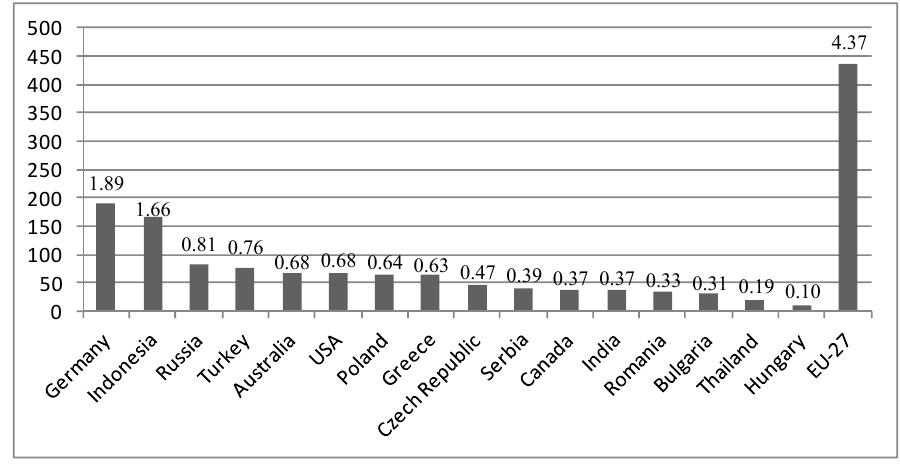
Figure 4. Lignite mining in the world in 2018 (million tons) [47].